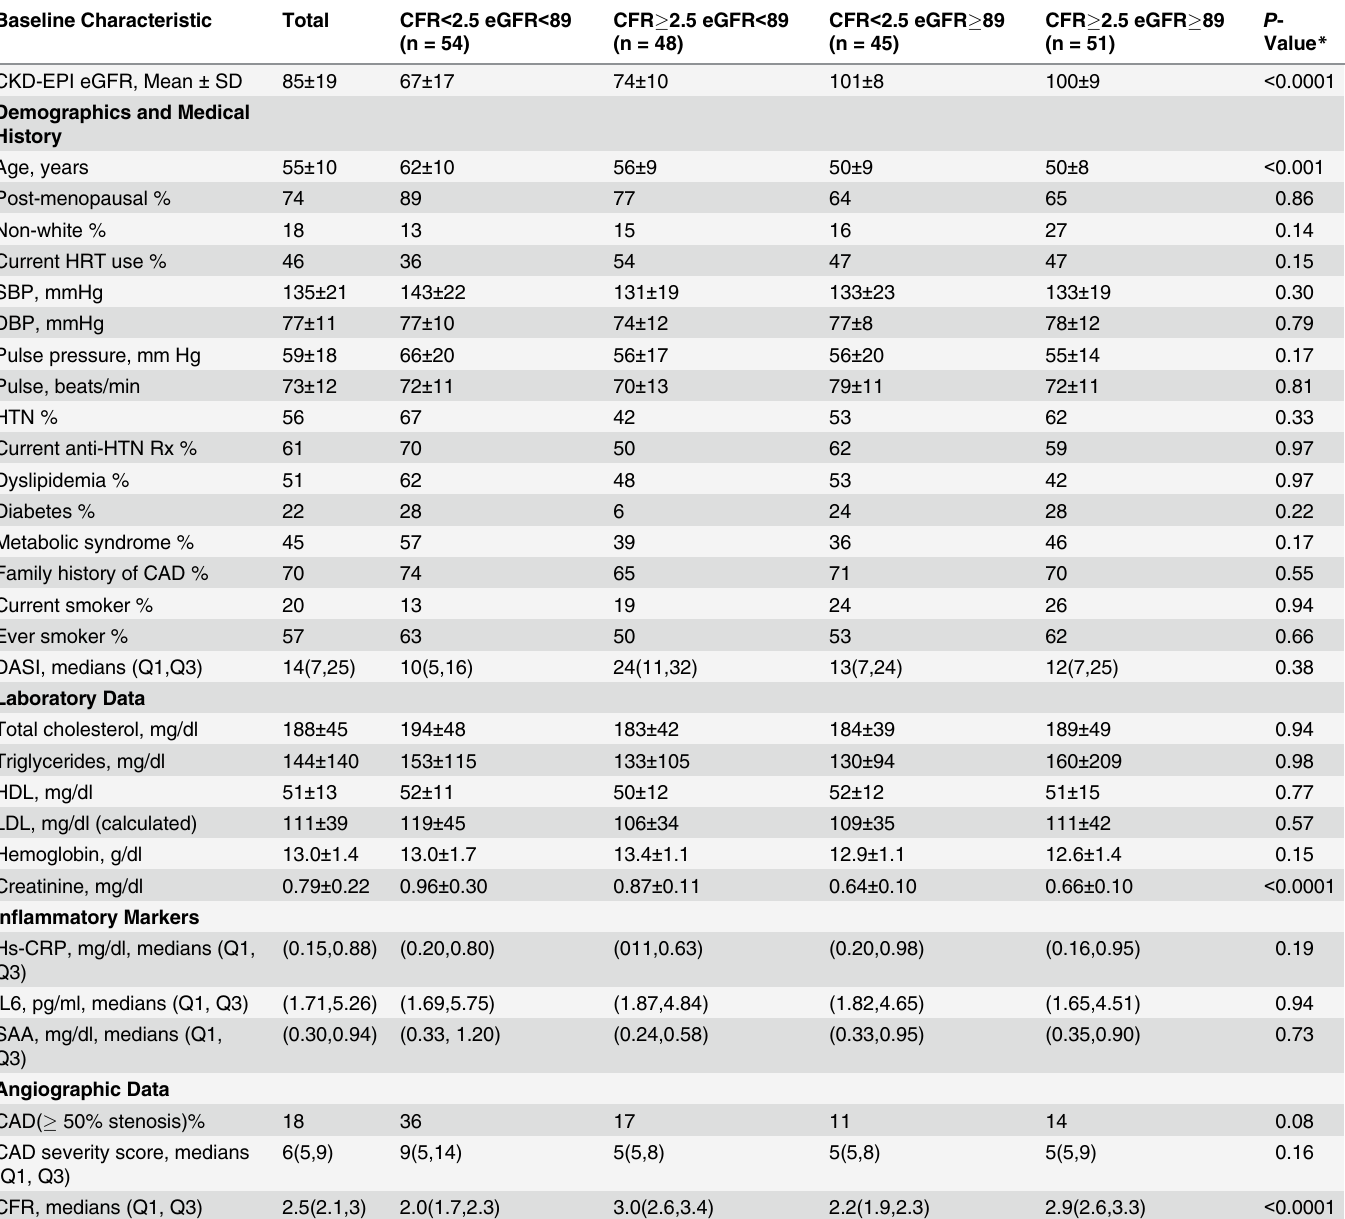
Table 1. Baseline characteristics of the study population, categorized by glomerular filtration rate (eGFR) and coronary flow reserve